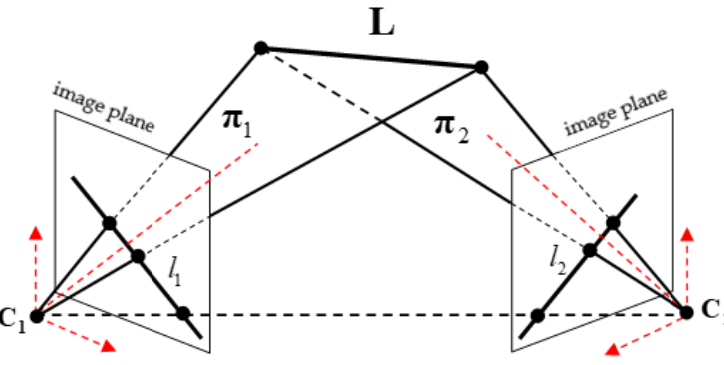
Figure 6. Geometric constraint of plane–plane intersection.